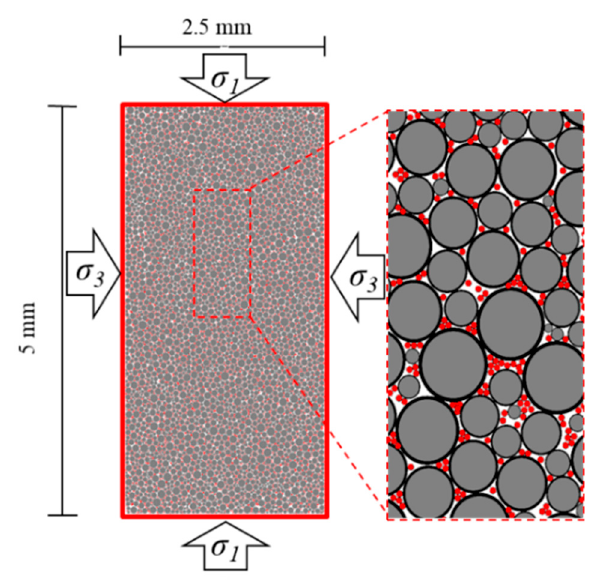
Figure 5. Distinct element method (DEM) simulation model of the methane hydrate-bearing specimen.